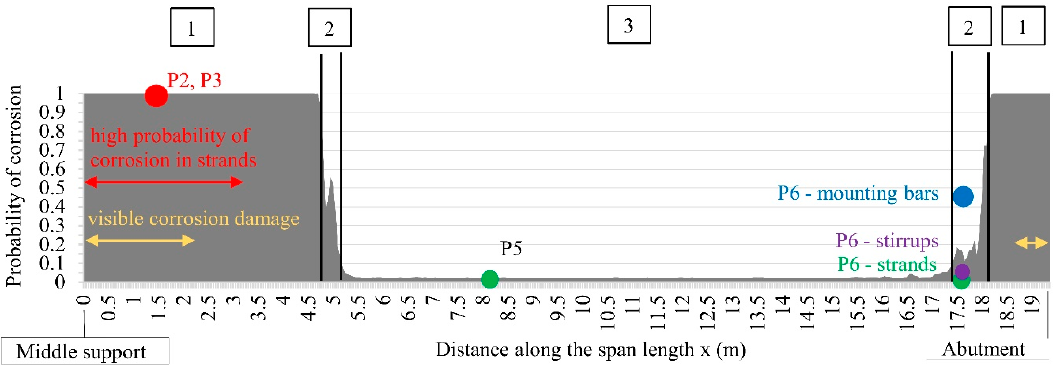
Figure 17. Comparison of calculated corrosion probability along Girder 2: grey area—corrosion probability based on HCP collected from support zones; dots—corrosion probability based on chloride concentrations; nos. 1, 2, 3—zones with high (>90%), uncertain, and low (<10%) corrosion probability, respectively.